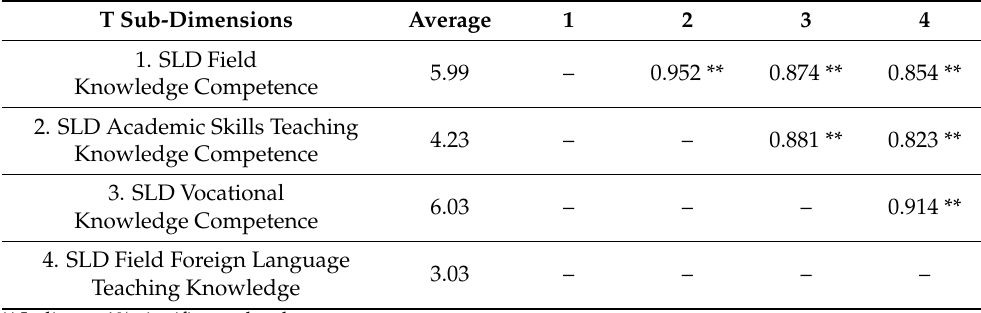
Table 6. Correlation analysis between sub-dimensions of participants’ proficiency in SLD. T Sub-Dimensions